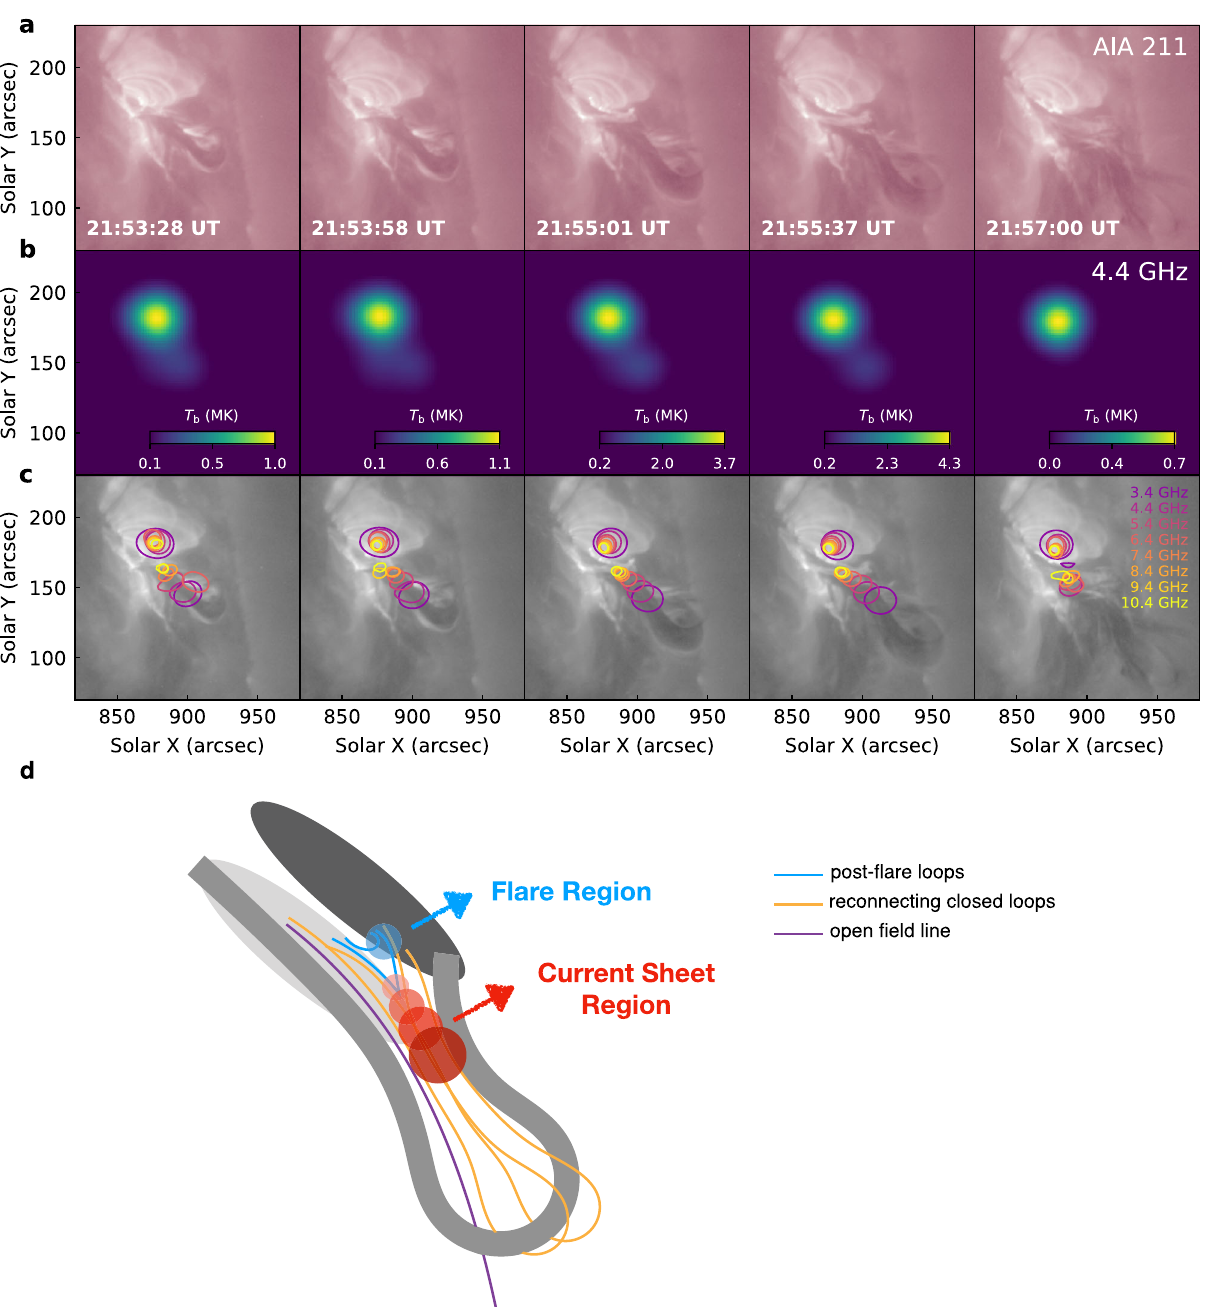
Fig. 2 | EUV and microwave emissions of the fl are. a SDO/AIA 211Å images showing the erupting fi lamentand induced EUVbrightenings. b EOVSAmicrowave images displaying the distribution and evolution of the fl are brightness tempera- ture, T b , at 4.4GHz. c SDO/AIA 211Å images with superimposed microwave con- tours. The color from purple to yellow correspond to frequencies from 3.4GHz to 10.4GHz. There are two groups of contours, each of which shows 80% of the highest T b in the strong and weak sources, respectively. d A schematic diagram